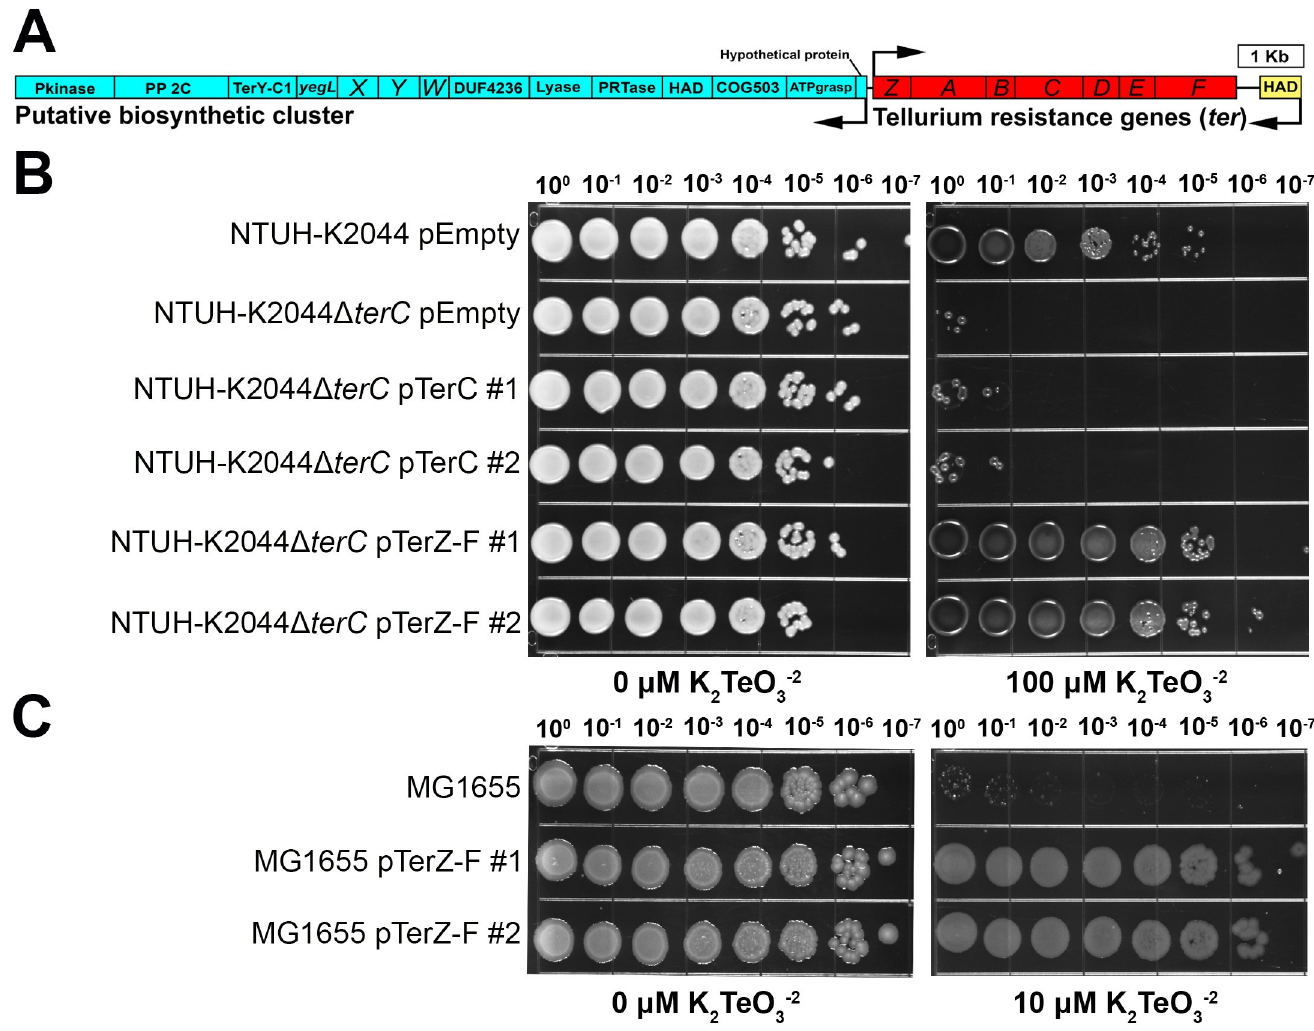
Fig 1. The Kp terZ-F genes are sufficient for TeO 3-2 resistance. (A) The ter locus is organized in two operons, a putative biosynthetic cluster and a TeO 3-2 resistance cluster. These sections are found on opposite DNA strands and are encoded bidirectionally. The representative ter locus from the hvKp strain NTUH-K2044 is shown. NTUH-K2044 containing the empty vector pACYC184, the isogenic Δ terC mutant (clone Kp2259) containing an empty vector, the pTerC, or the pTerZ-F plasmid (B), and the E . coli K12 strain MG1655 with or without the pTerZ-F plasmid (C) were grown on LB or LB containing 10 or 100 μ M K 2 TeO 3-2 to visualize inhibition of growth (dilution series 10 0 − 10 − 7 of overnight culture). Two representative clones (labeled #1 and #2) of NTUH-K2044 Δ terC containing the pTerC or the pTerZ-F plasmid and MG1655 containing the pTerZ-F plasmid are shown.